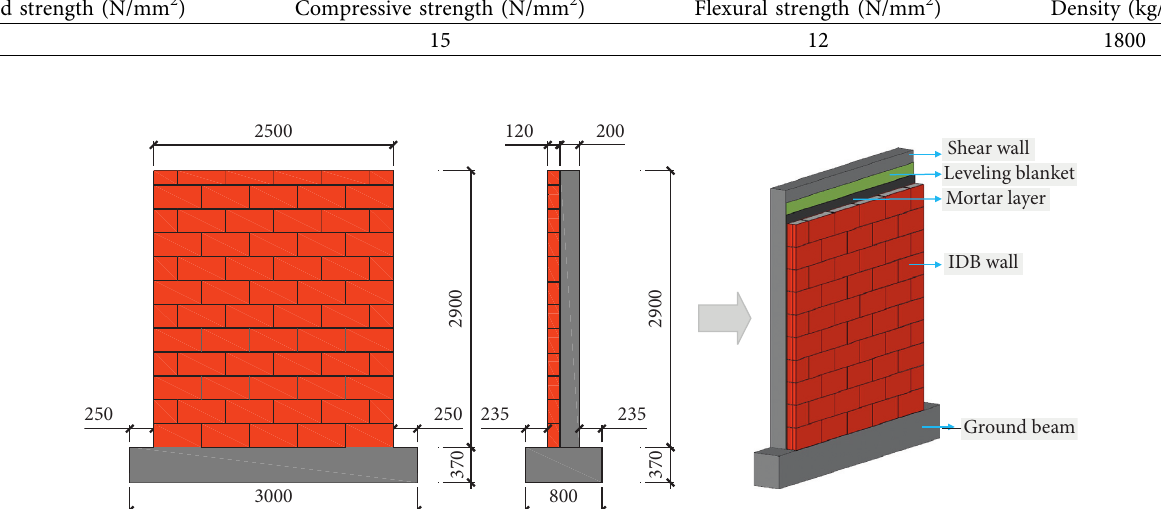
Figure 3: Dimensions of the